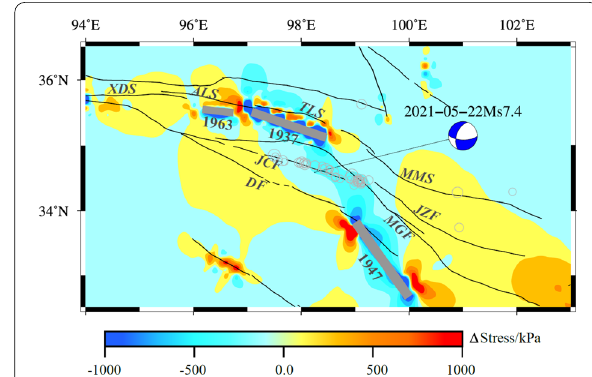
Fig. 6 The combined ΔCFS induced by 14 earthquakes at the depth of 10 km